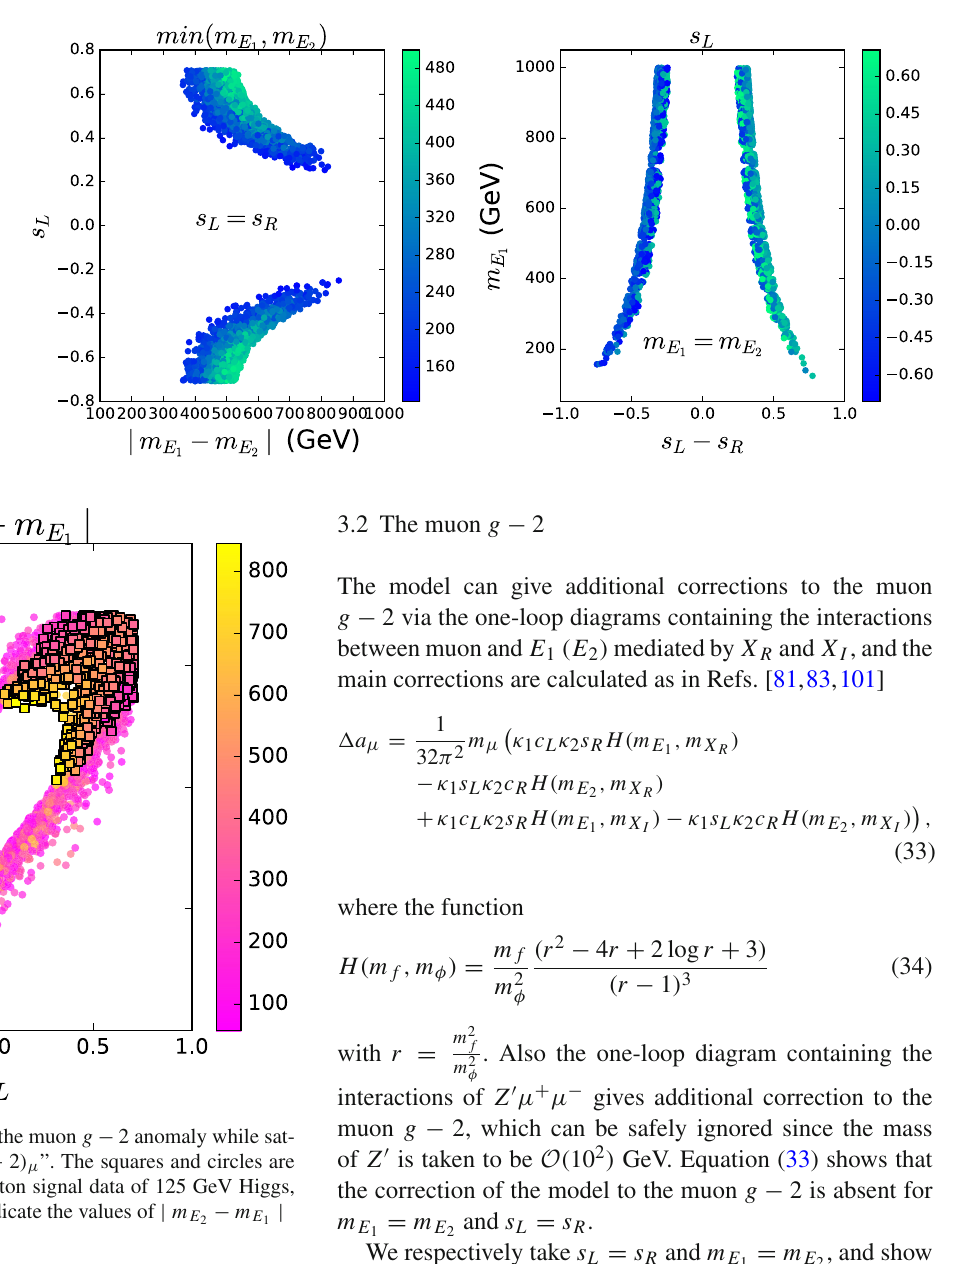
( 0 ) and (cid:15) NP ( 0 ) are zero, and WW ZZ